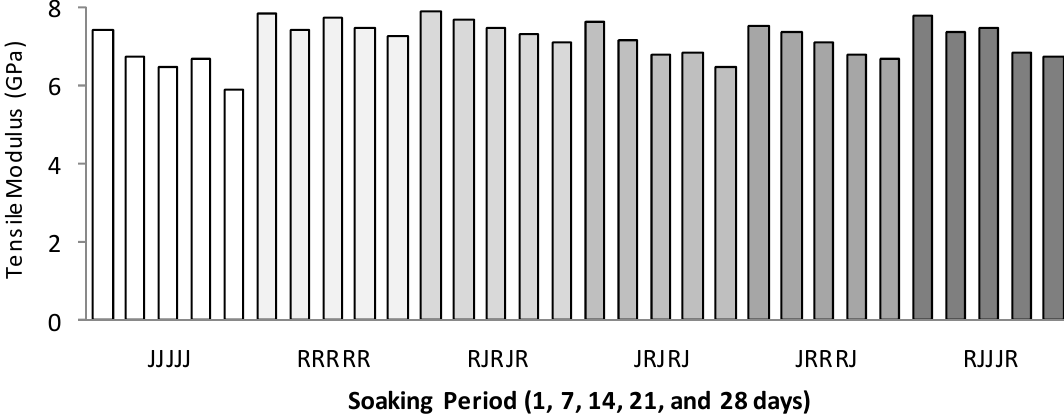
Figure 9. Water absorption behaviour on the tensile modulus of single and hybrid